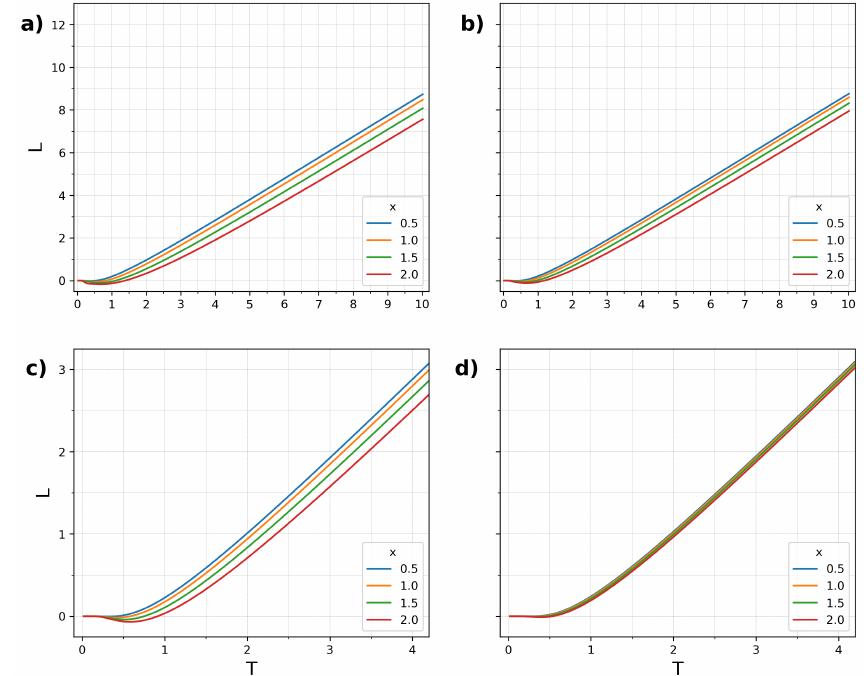
Figure 10. The mean value of ˆ L as a function of the temperature are displayed. The curves correspond to different values of the dimensionless coupling constant x , from the up to the down curve x takes the values 0.5, 1, 1.5, and 2, respectively. ( a – d ) stand for values of the asymmetry parameter